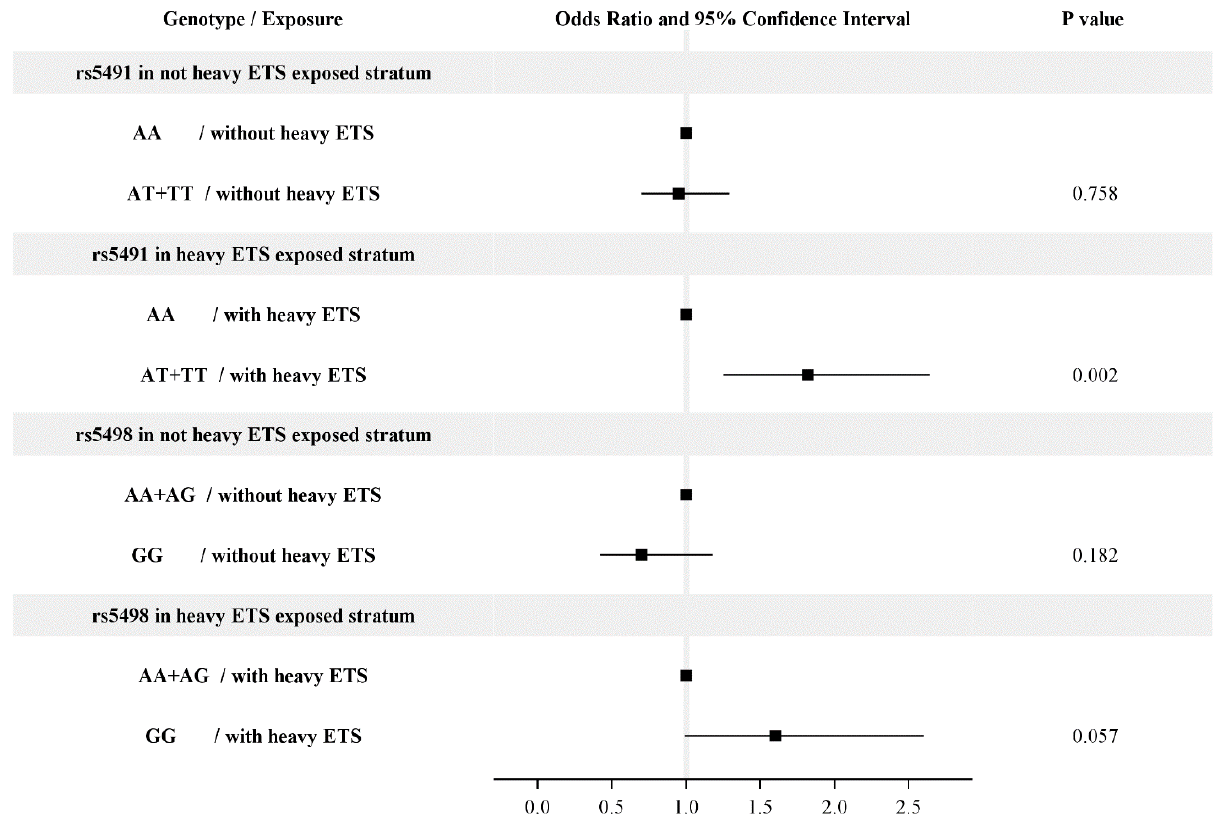
Figure 1. The interaction of exposure to environmental tobacco smoke (ETS) with rs5491 or rs5498 for asthma development. Models were adjusted for gender, grade, parental education level, and school location. Exposure to heavy ETS was defined as having more than one household smokers. The effect of rs5491 and rs5498 was modified by ETS ( p = 0.05 and 0.01,